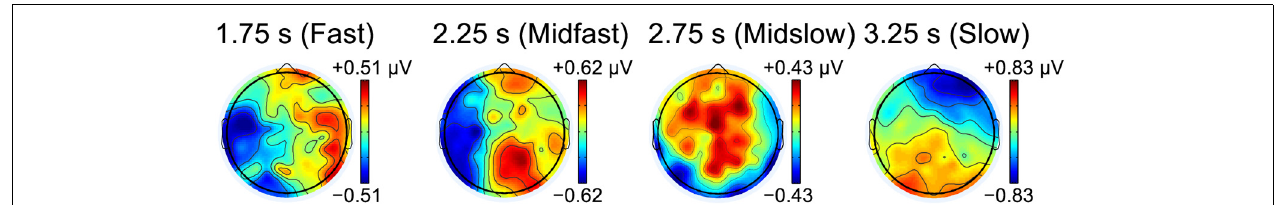
FIGURE 3 | Topographical distribution of the negativity at the different temporal distances created by the variation in presentation rate, indicated within parentheses. Average ERPs in the LAN time window (300–450ms) for the subtraction disagreement–agreement are